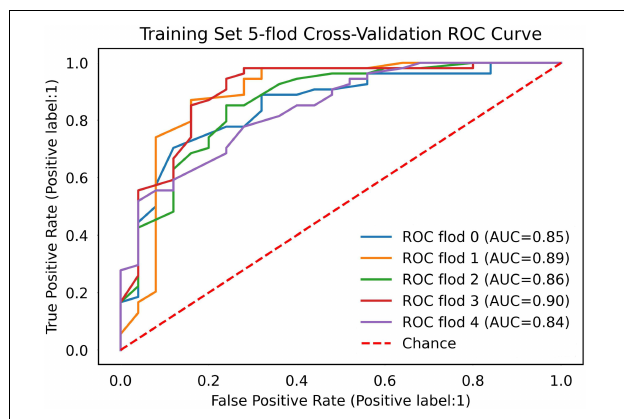
FIGURE 5 | The AUC of the DL model for predicting EVAR-related SAEs in the training set. AUC, area under the curve; DL, deep learning; SAEs, severe adverse events; EVAR, endovascular aneurysm